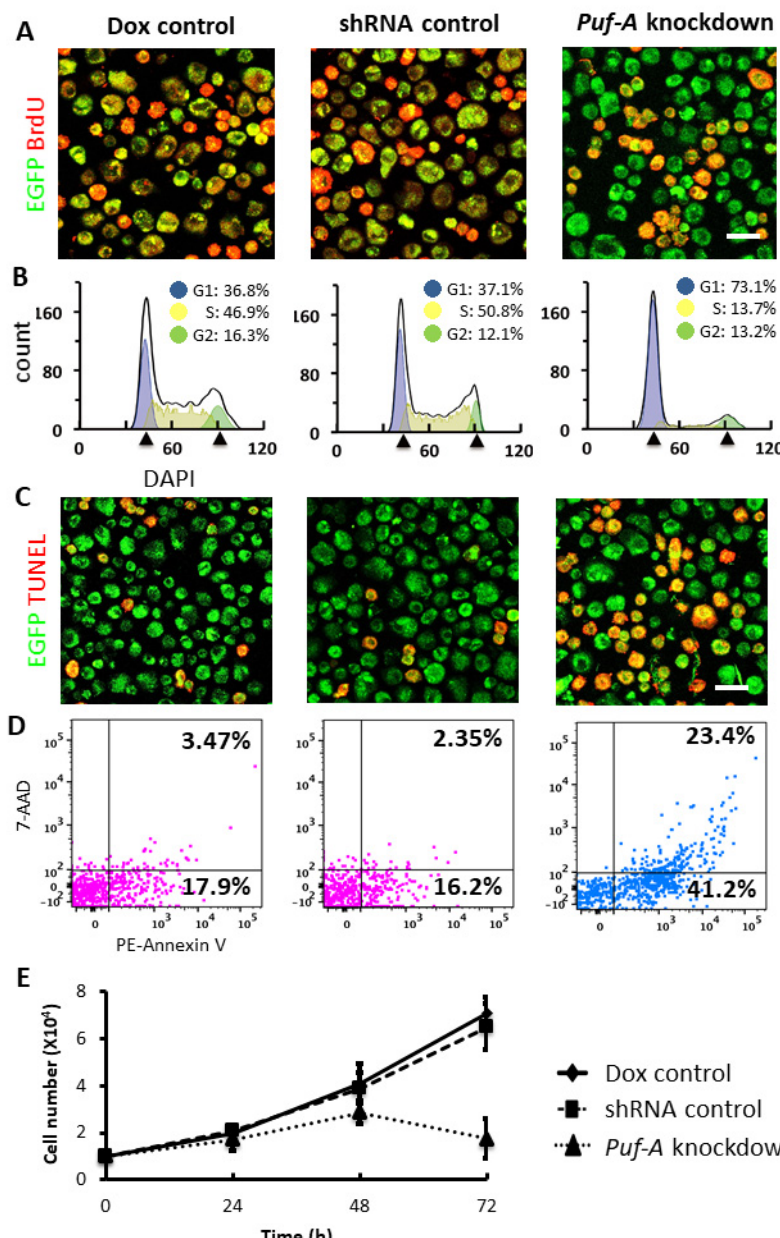
Figure 6. Puf-A knockdown impairs the growth of PGCs. ( A ): BrdU incorporation was conducted to detect the proliferation of PGCs. Most Oct4 -EGFP + PGCs (green) from Dox control and shRNA control embryos, were labeled with BrdU (red); however, upon Puf-A knockdown, less than a half of PGCs had BrdU incorporation. Scale bars, 20 µ m. ( B ) Flow cytometry analysis of the cell cycle distribution of PGCs. The percentage of PGCs in G1 phase increased from 37% (controls) to 73.1% ( Puf-A knockdown). The percentage of PGCs in S phase decreased from 48.9% (controls) to 13.7% ( Puf-A knockdown). ( C ) TUNEL labeling was performed to measure the apoptosis of PGCs. Half of Oct4 -EGFP + PGCs (green) from Puf-A knockdown embryos were labeled with TUNEL (red), while ( D ) Cell apoptosis and death analysis using PE Annexin V/7-AAD kit. The percentage of